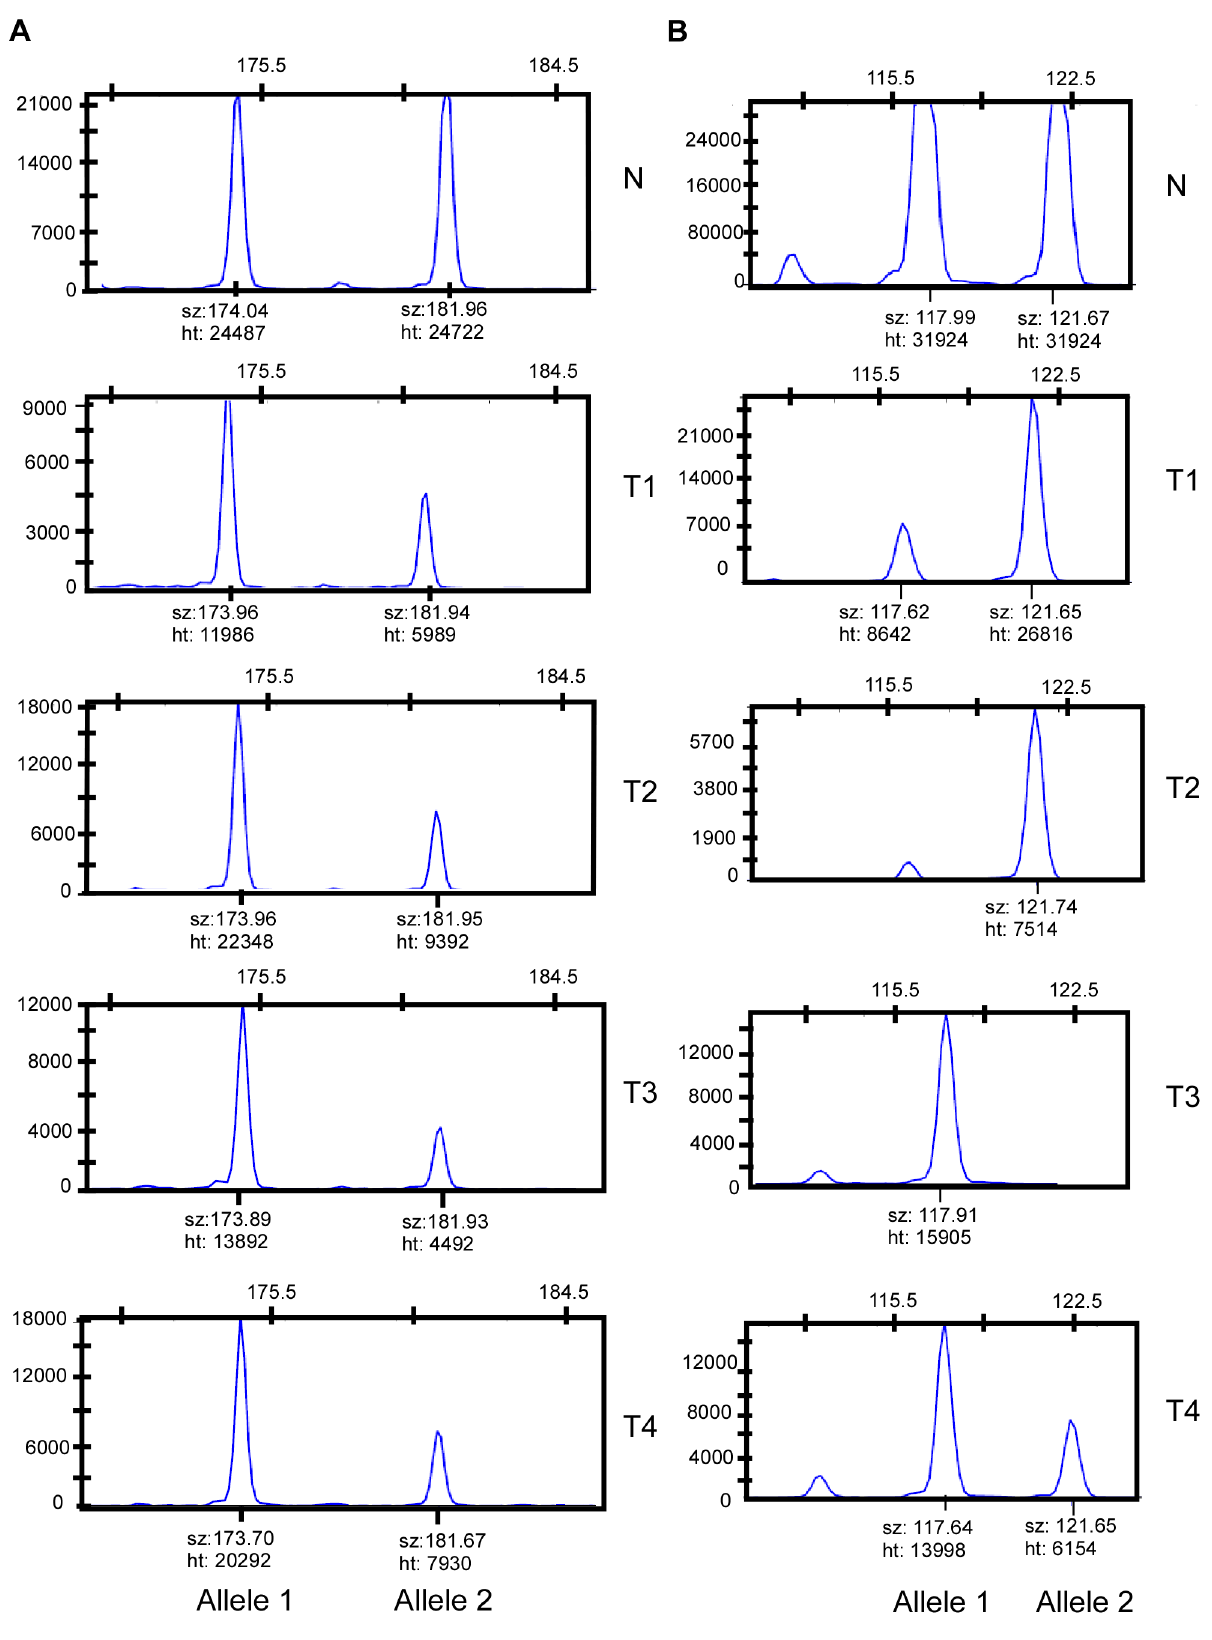
Figure 3. Loci with and without evidence of preferential allelic imbalance. (A) Microsatellite marker showing evidence of preferential allelic imbalance. Four tumors from one individual were typed for microsatellite marker D3S3045. Compared to blood DNA, all four tumors showed